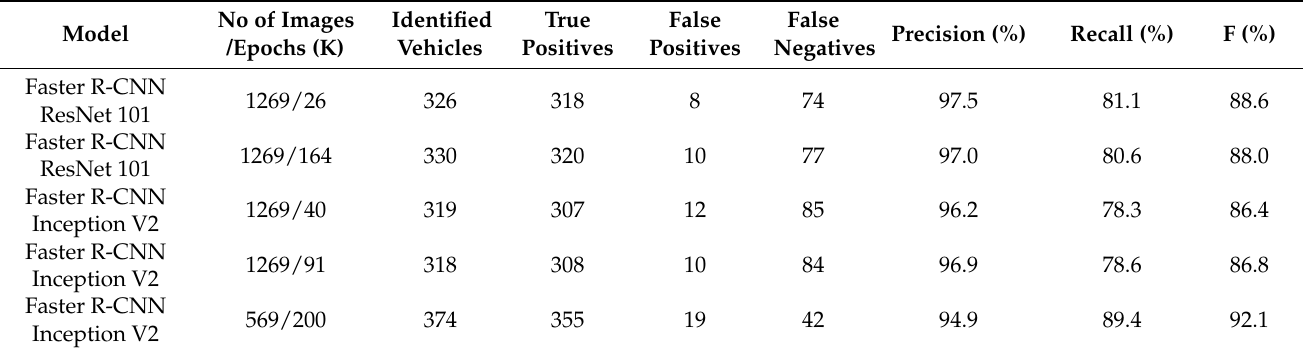
Table 1. Faster R-CNN post-training evaluation of 50 ground truth